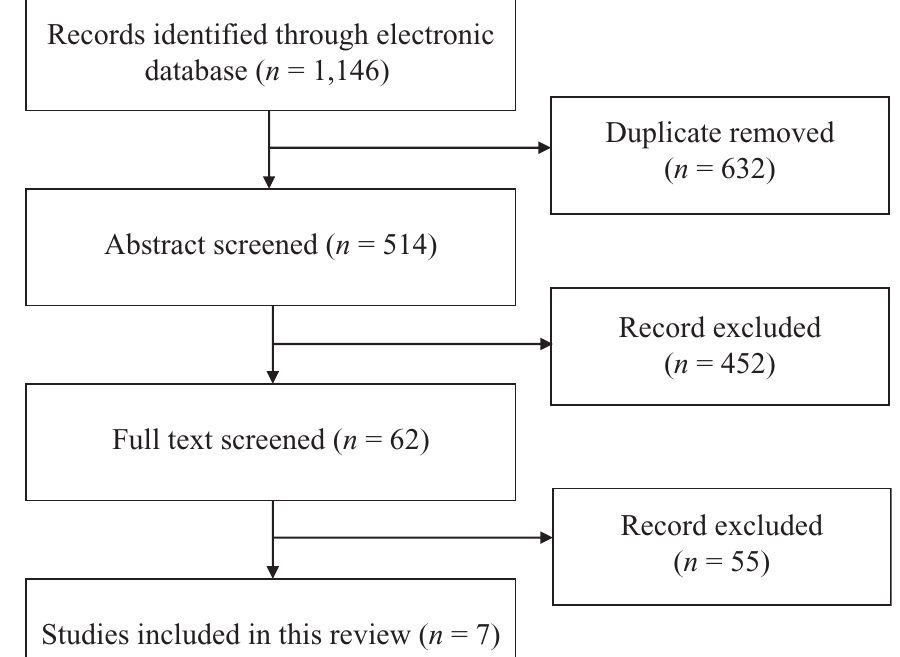
Figure 1. The review process